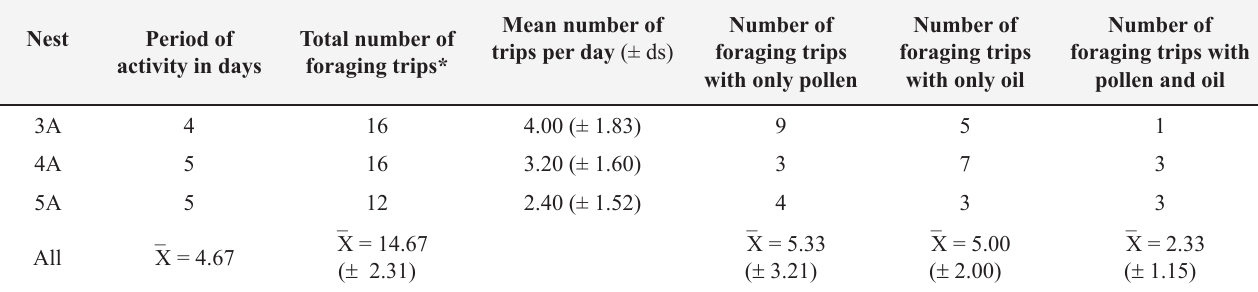
Table 1. Period of activity (in days) by females of Epicharis dejeanii in November 2017, during a survey conducted, from 6:00 am to 6:00 pm, at Ilha do Superagui, south of Brazil, in a nest aggregation. It is also shown the total number of foraging trips along the study period, mean number of foraging trips per day (± sd) and number of foraging trips for different types of resources (oil, pollen and oil + pollen). The observations were carried out at the entrance three nests, by two observers. In all nests, when the observations started, the females had already initiated the cell provisioning activities.